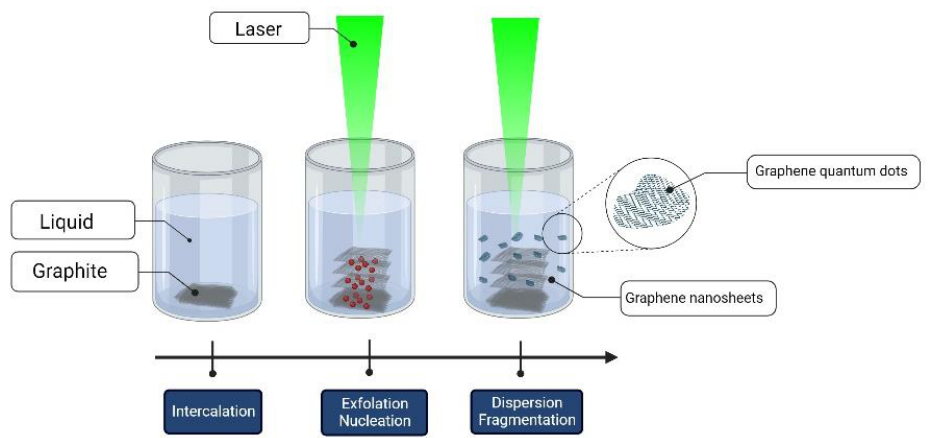
Figure 8. Graphene formation mechanism (Created with BioRender.com).